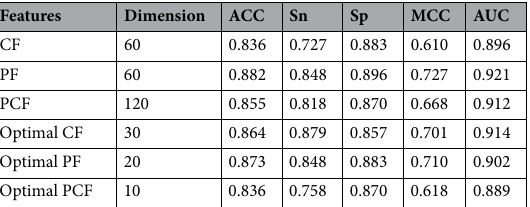
Table 3. Independent test results for different feature representations using class and probabilistic information.